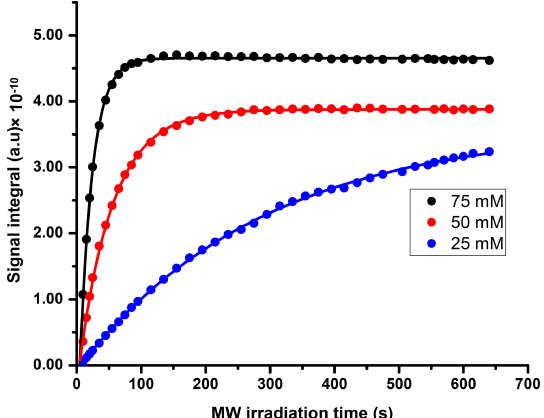
Figure D1. Comparative plot of liquid-state 13 C signal integrals between two different sample transfer line inner diameters at the same dissolution